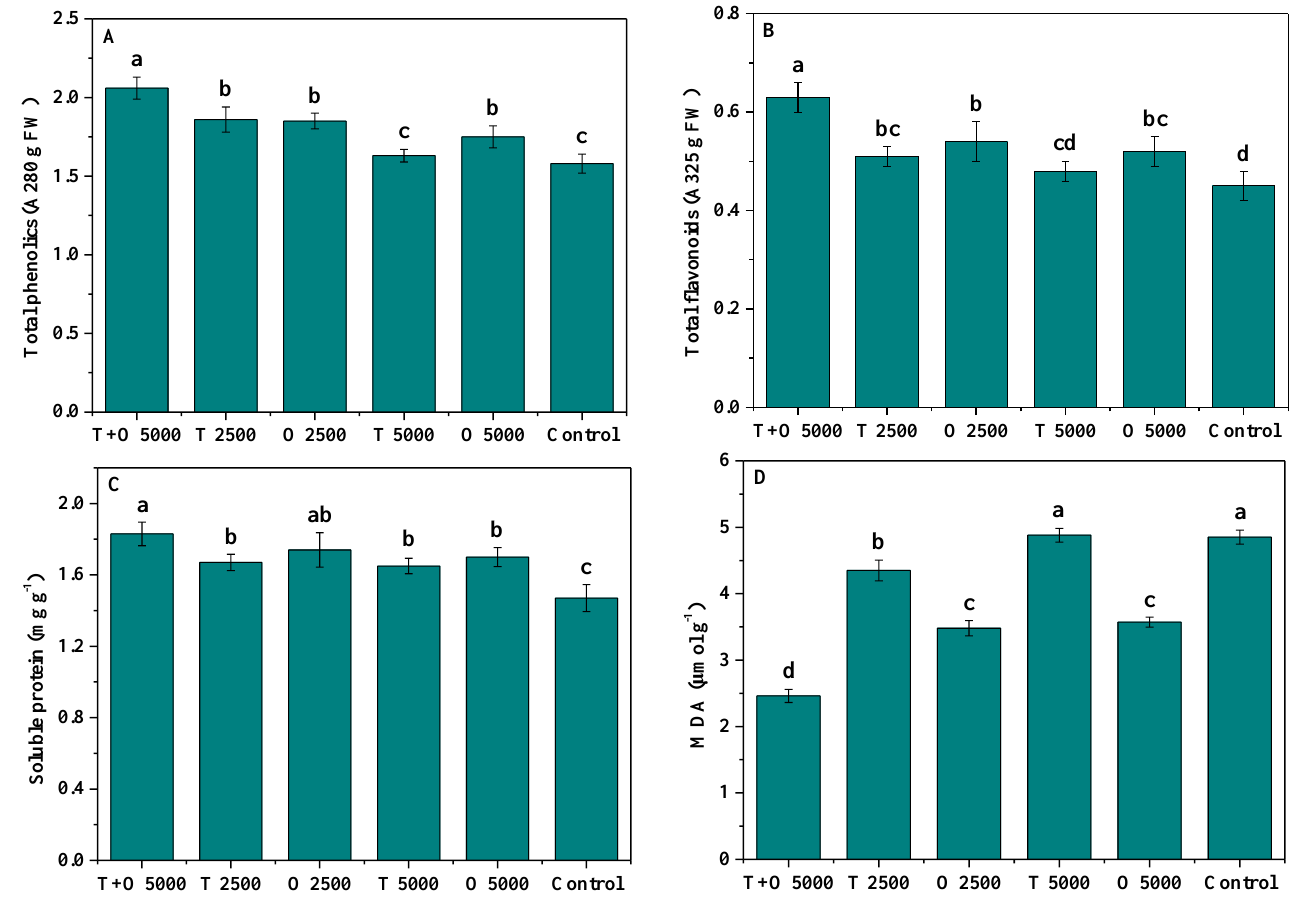
Figure 1. The effects of tebuconazole and oligosaccharins on phenolics ( A ) (unit: A280 g FW), flavonoids ( B ) (unit: A325 g FW), soluble protein ( C ) (unit: mg g − 1 ) and MDA ( D ) (unit: µ mol g − 1 ) in kiwifruit. The mean ± SD (n = 3) of three replicates is shown. The significant differences at 5% ( p < 0.05) are represented as different small letters.